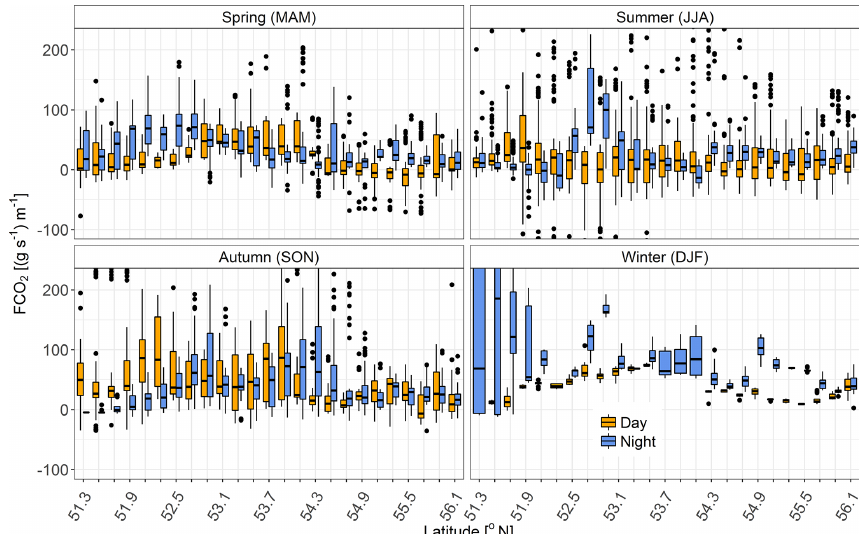
Figure 10. Box and whisker plots of 5min binned averages of CO 2 fluxes along the route of the ferry (latitude bin width: 0.2 ◦ ) segregated into day and night contributions. The horizontal bar within each box corresponds to the median for a given latitude bin, the upper and lower hinges represent the 75th and 25th quantiles, respectively, and the upper and lower whiskers indicate the largest–smallest observation less– greater than or equal to upper–lower hinge ± 1 . 5 ∗ IQR (inter-quantile range), respectively. The outliers are represented by solid circles and arithmetic means by red diamonds. The flux is integrated over the height of the planetary boundary layer and expressed in units of mass flux per metre travelled crosswind within each latitude bin per unit time.